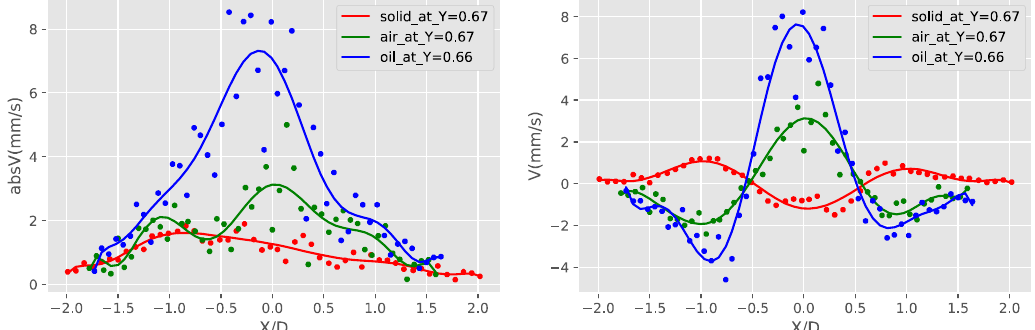
Figure 17. Comparison of the absolute velocities (absV) and Y-component velocity (V) of the three types of obstruction Y/D = 0.66 (location of the liquid droplet velocity peak).